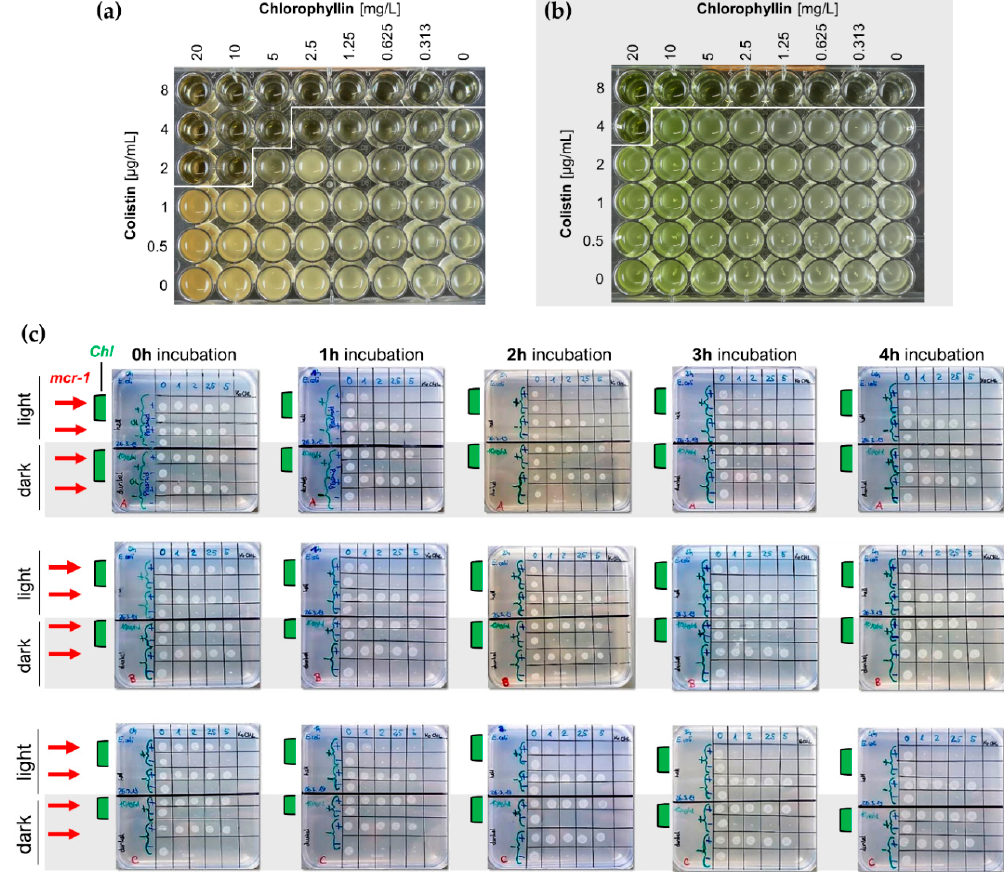
Figure 6. ( a , b ) Broth microdilution plates for MIC determination for colistin / chlorophyllin combinations under ( a ) illuminated and ( b ) dark conditions; ( c ) LB agar plates (n = 3) for the evaluation of CFU ability of wild type and mcr-1 -positive (red arrows) E. coli after incubation to chlorophyllin-colistin combinations. Liquid cultures of E. coli DH5 α were supplemented with 10 mg/L chlorophyllin (Chl, samples with green bars) and different colistin concentrations. Cells grew either illuminated with 12 mW/cm 2 or protected from light. Samples (2.5 µL) were drawn at different time points (1 h, 2 h, 3 h, 4 h) and transferred onto LB agar plates. After overnight incubation at 37 °C in the dark, colony growth was analyzed.